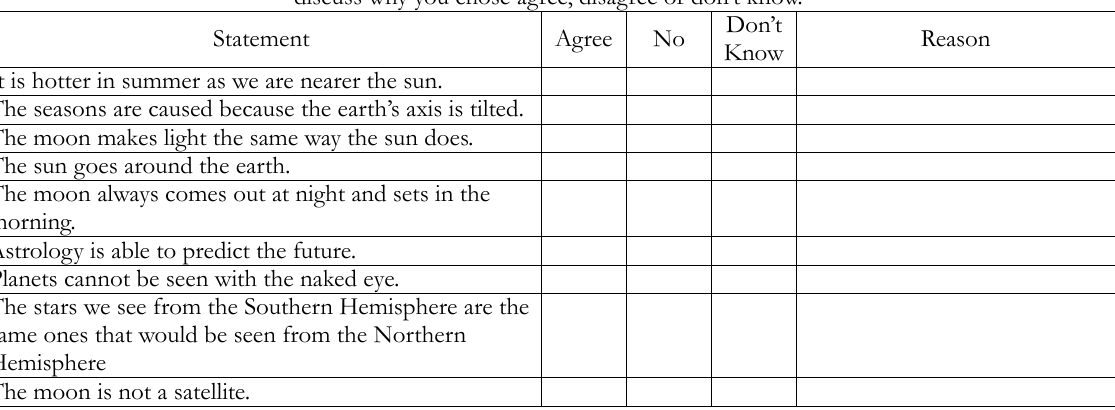
Table 1. Common ideas in Astronomy